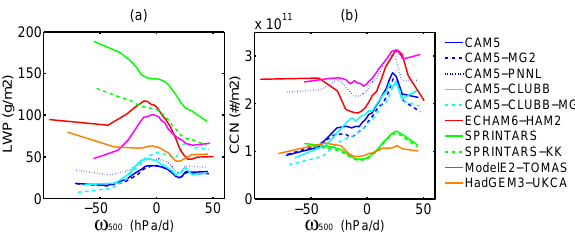
Figure 1. (a) LWP and (b) column-integrated CCN (at 0.1% super- saturation) as a function of 500hPa vertical pressure velocity ( ω 500 ) derived from different models: CAM5 (blue solid line), CAM5- MG2 (blue dashed line), CAM5-PNNL (blue dotted line), CAM5- CLUBB (cyan solid line), CAM5-CLUBB-MG2 (cyan dashed line), ECHAM6-HAM2 (red solid line), SPRINTARS (green solid line), SPRINTARS-KK (green dashed line), ModelE2-TOMAS (purple solid line) and HadGEM3-UKCA (orange solid line). Figure 2. Same as Fig. 1a, but for (a) the sensitivity of LWP to the change of CCN ( λ) , (b) relative enhancement of liquid water path (dlnLWP) and (c) relative enhancement of cloud condensation nuclei (dlnCCN) from pre-industrial (PI) to present day